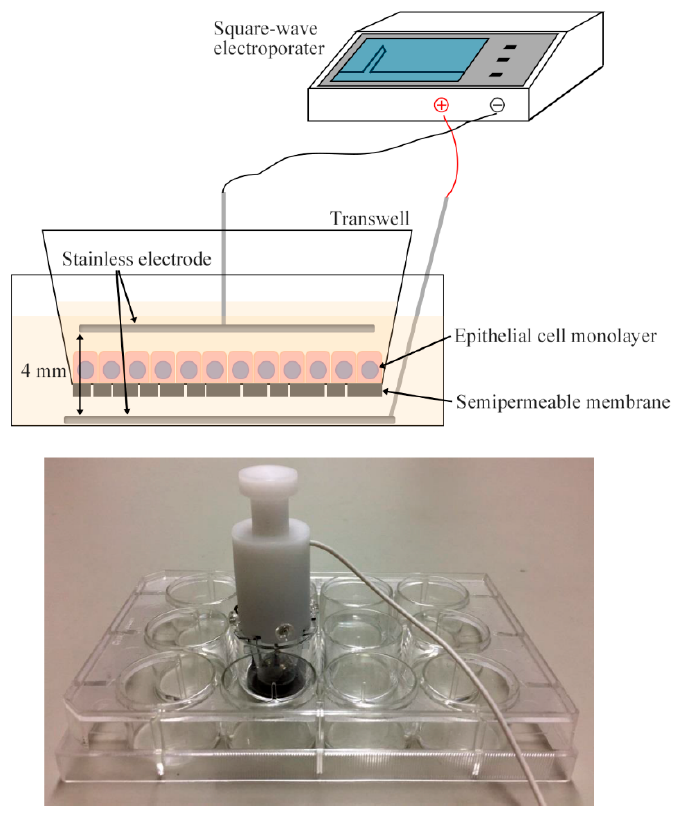
Figure 2. A new electroporation system devised for the polarized 2D cell culture. A pair of stainless-steel circle electrodes were devised so as to adjust to the 12-well plate culture system. The lower electrode was set on the well bottom, and the upper electrode was placed parallel to the Transwell membrane at a distance of 4 mm from the lower electrode. The electrodes were connected with a square-wave electroporator, which was set to generate single pulse at 40 V for 10 msec. Upper, schematic presentation; lower, a photograph of the electrode set in a 12-well plate.